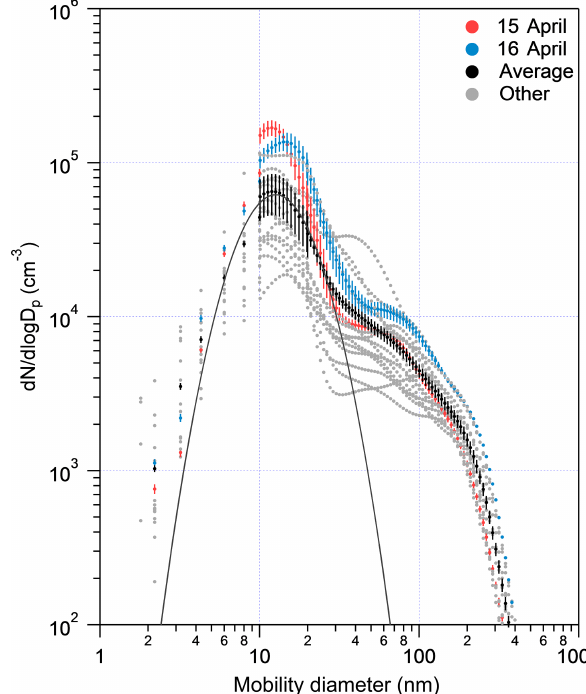
Figure 7. Number size distributions during high airport emission loads. The 2h averaged size distributions of the time series pre- sented in Fig. 6 shows particle plumes on 15 April (red) and 16 April (blue) yielding high particle number concentrations and elevated NO and NO 2 concentrations. Other airport emission plumes during the measurement period are shown in grey. All number size distri- butions were averaged (black). The distribution was fitted using a log-normal function (dark grey line), and the resulting mode diam- eter is at